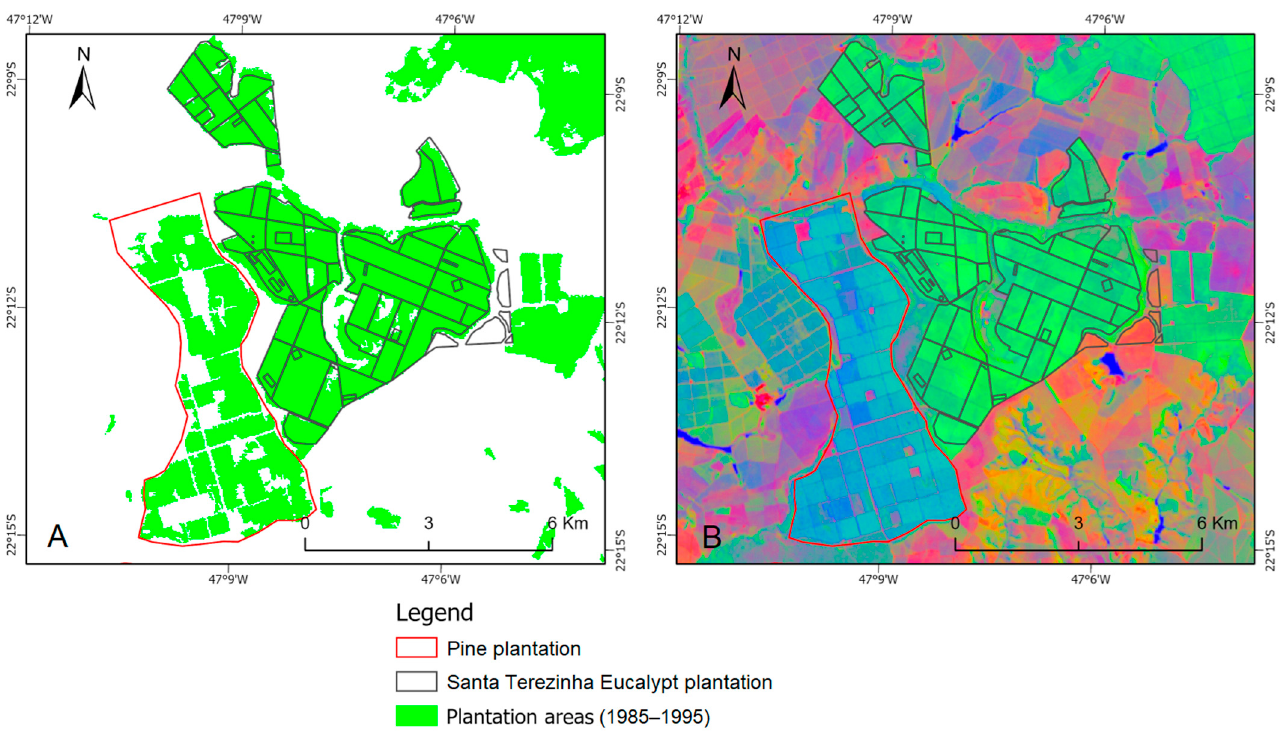
Figure 11. ( A ) Classification of forest plantation areas in the pilot area during the first study period (1985–1995), based on the TM mosaic of maximum vegetation fraction values. ( B ) Median image RGB composition of soil (R), vegetation (G), and shade (B) fraction images for 1985–1995 time period. In opposition, Figure 12 shows the classification of eucalypt plantation areas from 2013 to 2021 using the 30 m Landsat OLI mosaics composed of the maximum vegetation fraction values. Since this classification uses multiple images for a time series, the Campininha Pine Experimental Station had been harvested and was in a transition stage. Therefore, the classification did not map these areas as forest plantations as expected. On the other hand, the Santa Terezinha site still presents the rotation cycles of eucalypt plantations in the same